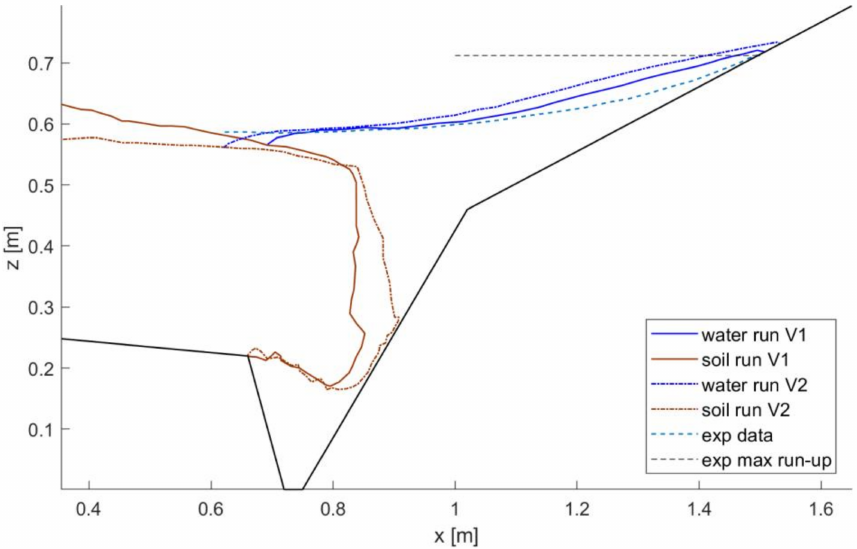
Figure 7. Comparison of maximum simulated run-up at t = 1.35 s for change in the angle of internal